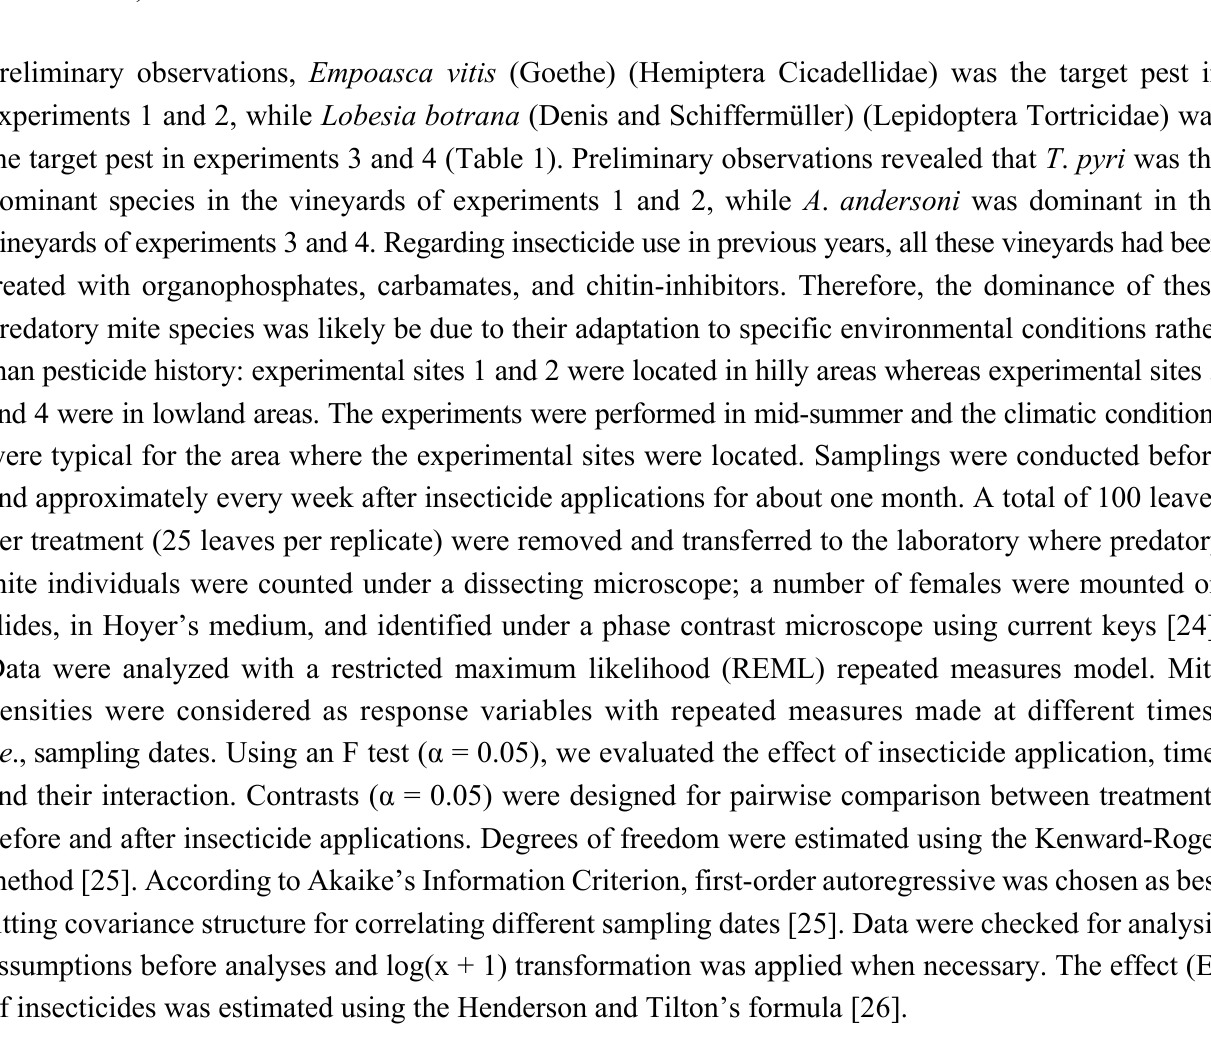
Table 1. Experimental design and insecticides applied in the four